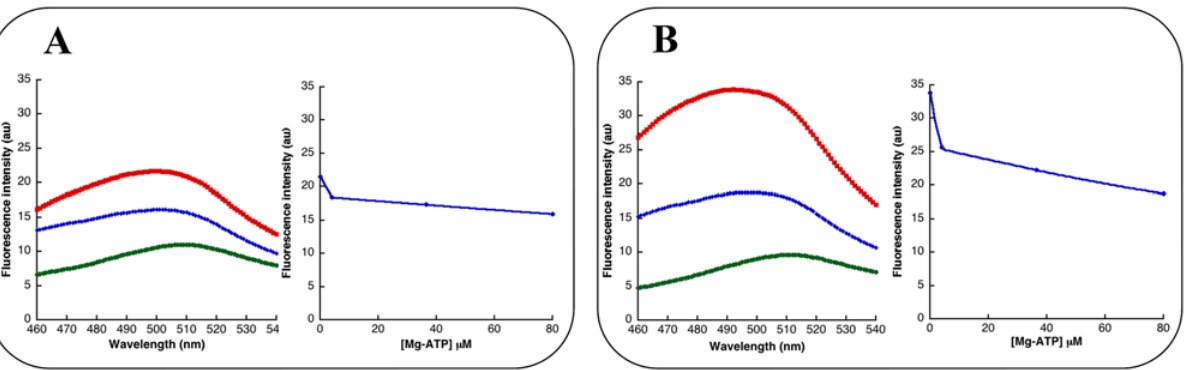
Fig 6. ANS binding to IMPDHpa and IMPDHbt. ( A ) Left panel: ANS fluorescence spectra alone at 10 μ M (green), in the presence of 1 μ M IMPDHpa without (red) or with 100 μ M ATP (blue). Right panel: fluorescence intensity measured at 495 nm as a function of MgATP concentration. ( B ) The same curves for